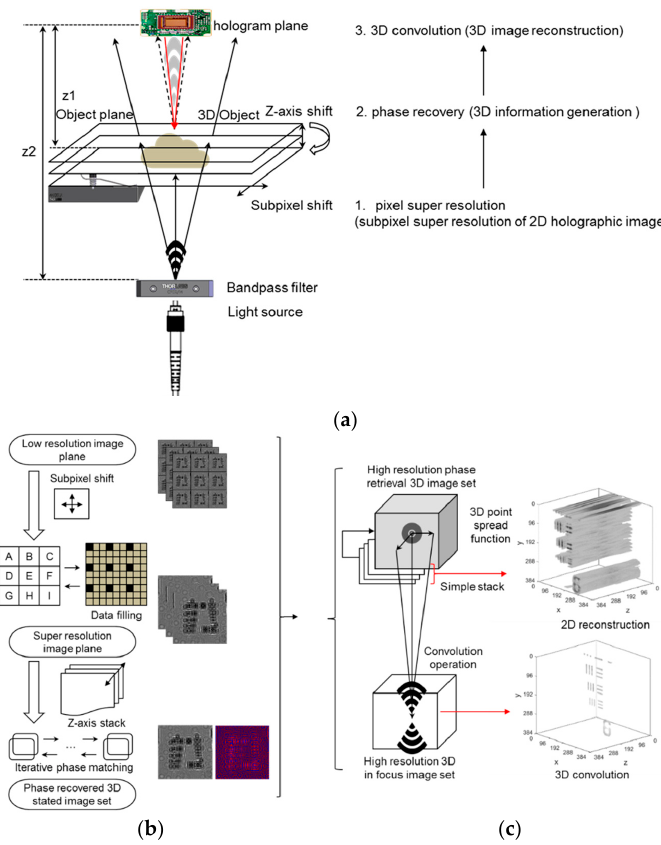
Figure 1. A schematic description of the experiment setup and the proposed algorithm for three-dimensional super-resolution digital in-line holographic microscopy using a volumetric deconvolution approach. ( a ) A low-resolution image acquisition apparatus using the in-line holographic approach. By using a narrow bandpass filter and light source, connected with an optical fiber, temporally coherent light is propagated along an object plane and generates an interference image at an image sensor, i.e., detector plane. The object plane moves with the sub-pixel shift in the X and Y direction for the pixel-super-resolution process and Z -axis shift for multi-height phase recovery. ( b ) Phase recovered high-resolution hologram image generation. For high-resolution three-dimensional deconvolution, a phase recovered complex hologram image is generated by the pixel-super-resolution process and multi-height phase recovery algorithm. ( c ) Three-dimensional volumetric imaging, which is constructed by the deconvolution process. The complex hologram image is back propagated to a series of Z -axis distances to generate a Z -stacked complex object field. Then, a clearly focused high-resolution volumetric object image is constructed by the three-dimensional deconvolution process with a simulated complex point spread function.